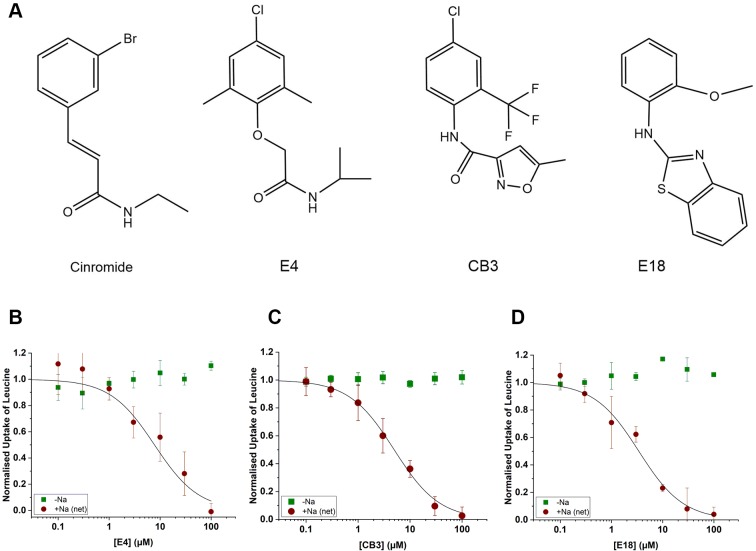
Properties of second generation inhibitors of B0AT1. Inhibitors E4, CB3, and E18 were identified by high-throughput screening. The established B0AT1 inhibitor cinromide is shown for comparison (A). Inhibition of B0AT1 activity (red symbols B–D) was tested in CHO-BC cells using a radioactive uptake assay (n = 3, e = 3). The assay allows to test the specificity of the inhibitors against the endogenous LAT1 transporter (green symbols B–D).